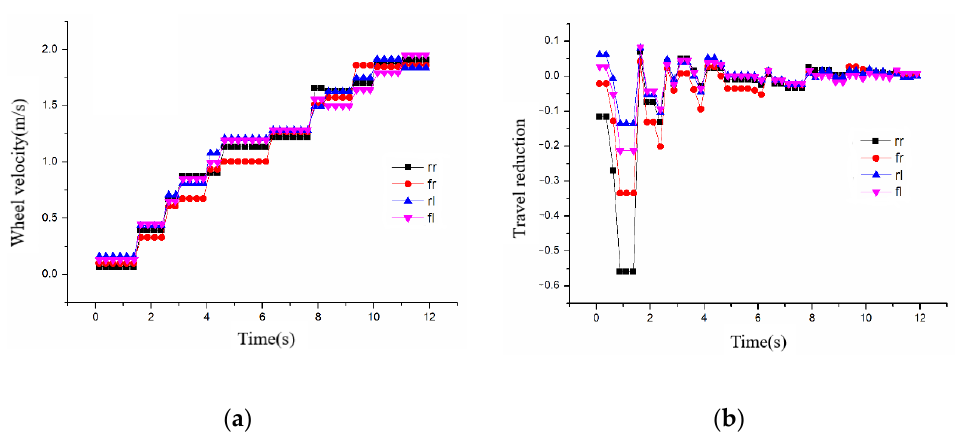
Figure 17. Wheel velocity and travel reduction of non-controlled strategy. ( a ) Wheel velocity; ( b ) Travel reduction.